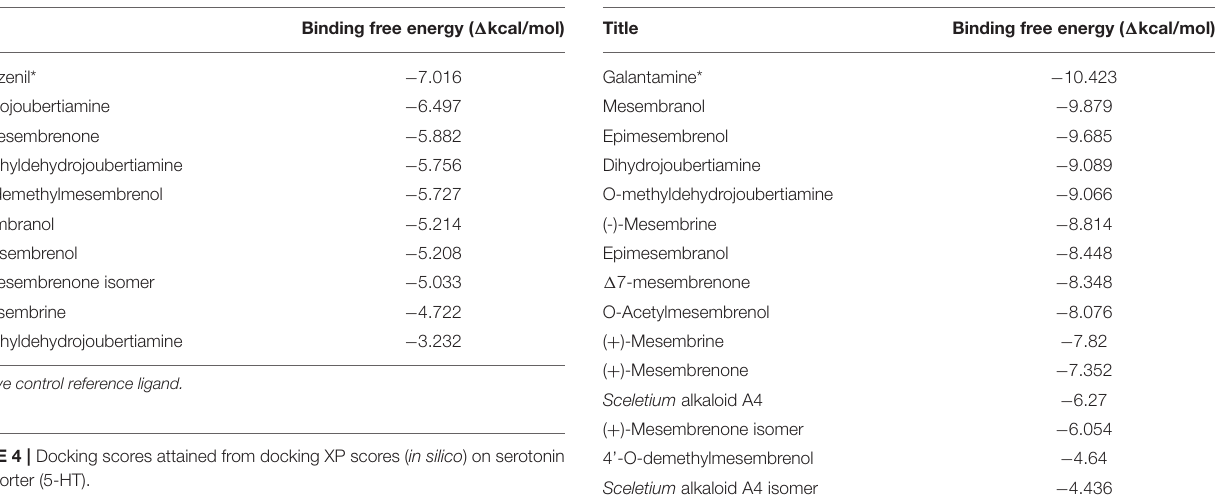
TABLE 5 | Docking scores attained from docking XP scores ( in silico ) on Acetylcholinesterase